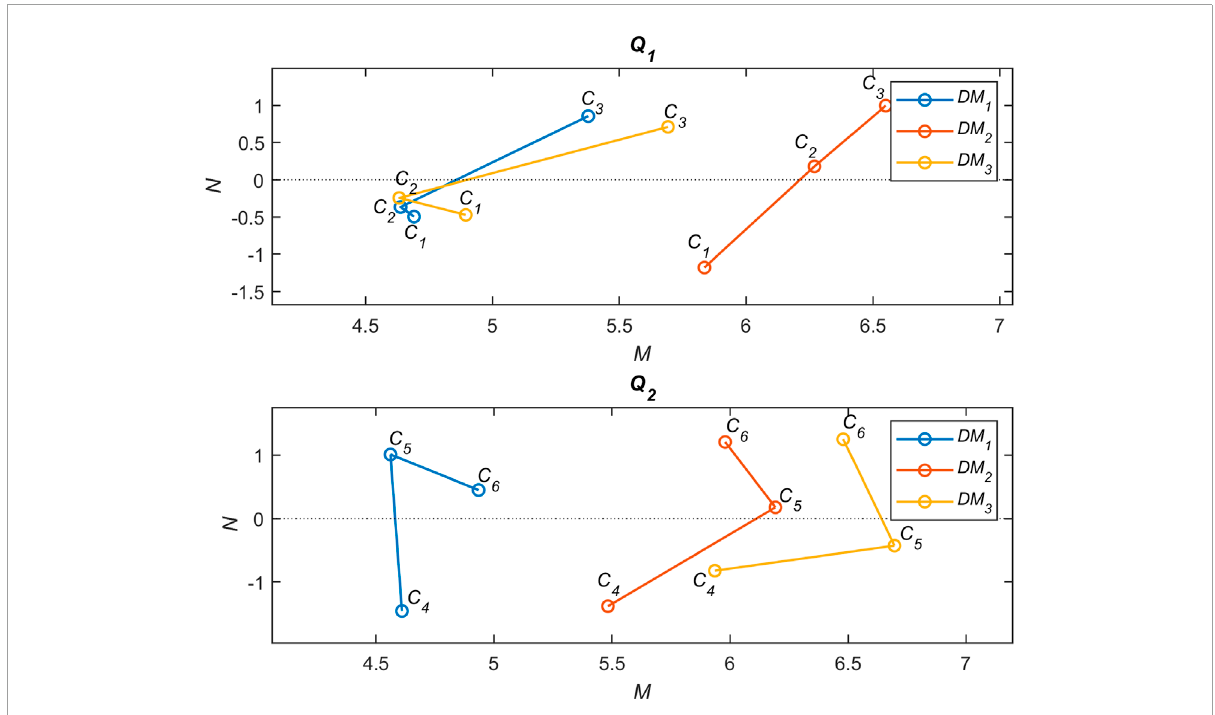
FIGURE 7 Centrality and causality of criteria based on Z-DEMATEL.